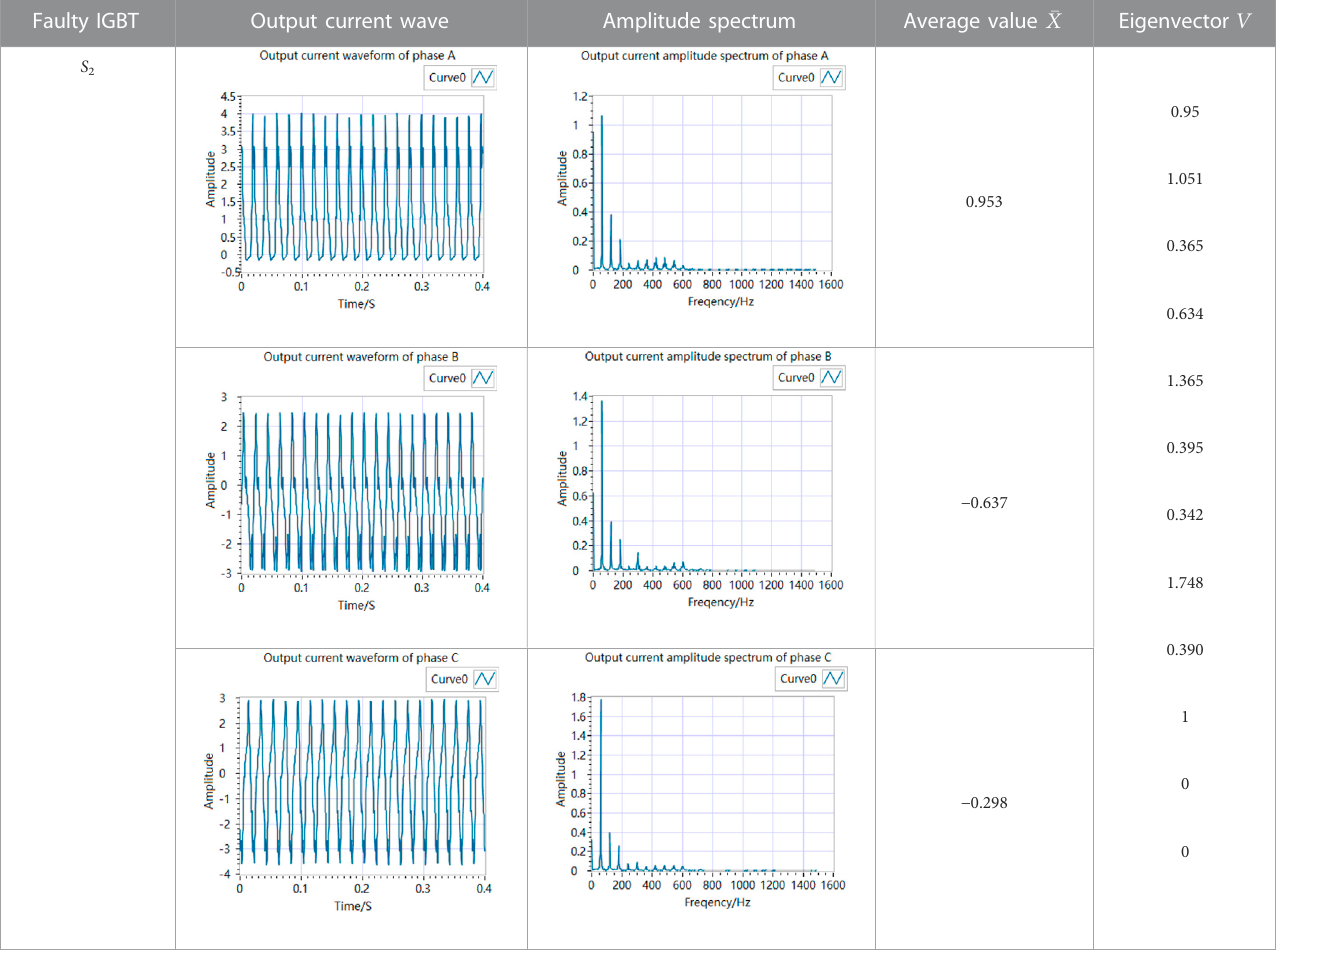
There are six cases when the OC fault happens on single IGBT. There are 15 cases when the OC fault happens on two IGBTs at the same time.